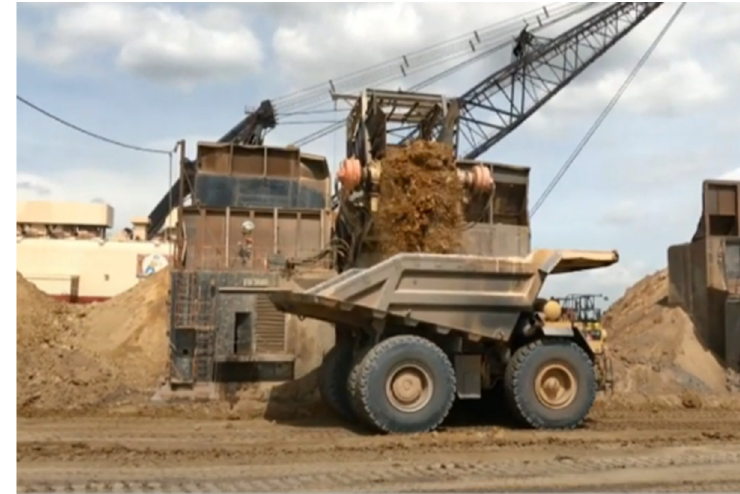
Figure 4. Feeding and Loading equipment (Colombia) [23].